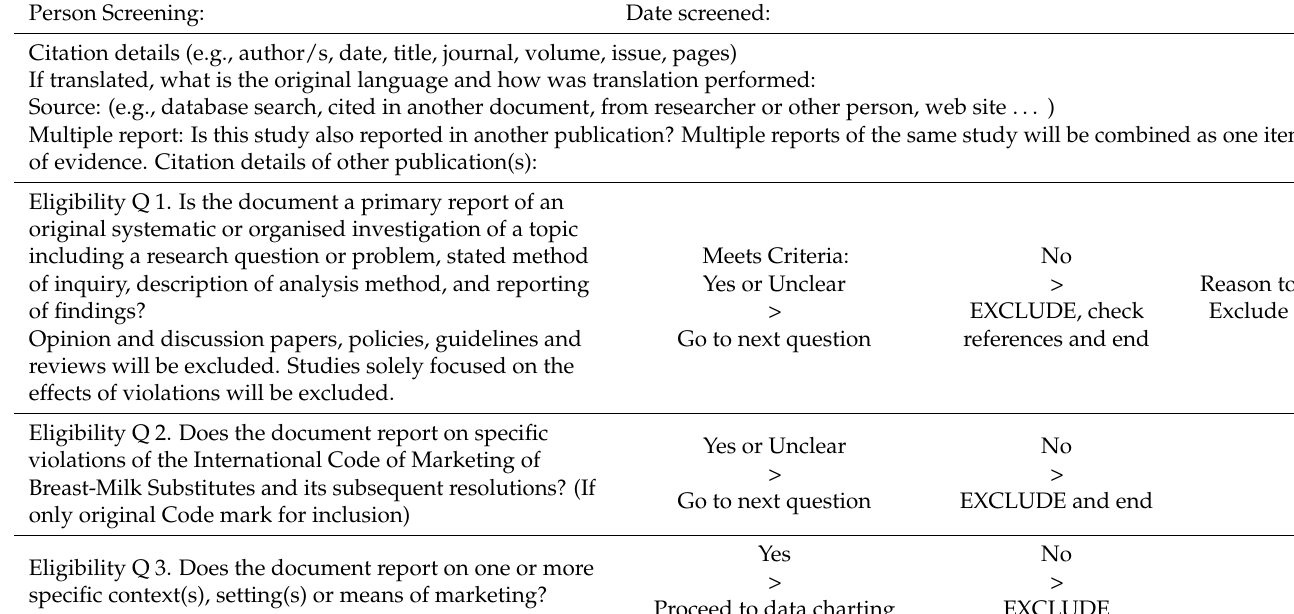
Table A3. Screening of items of